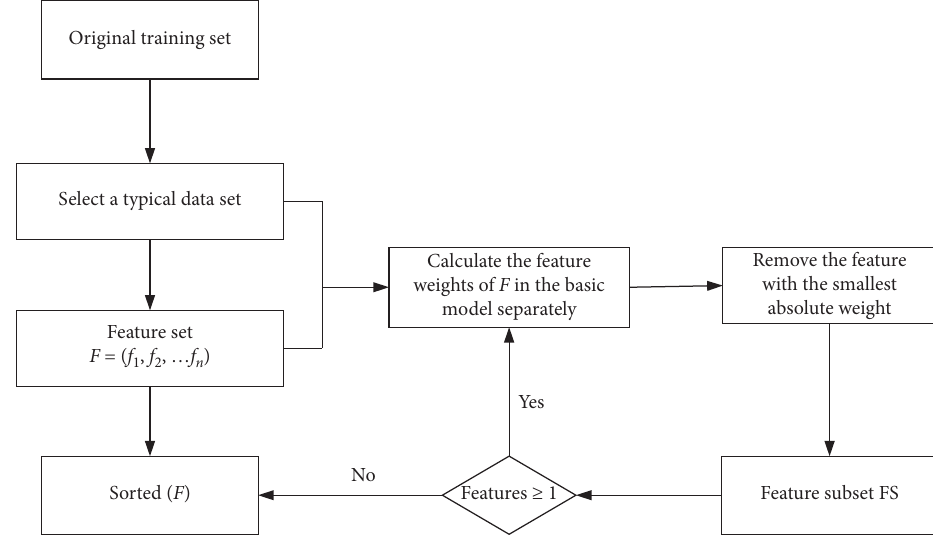
Figure 2: Feature selection algorithm